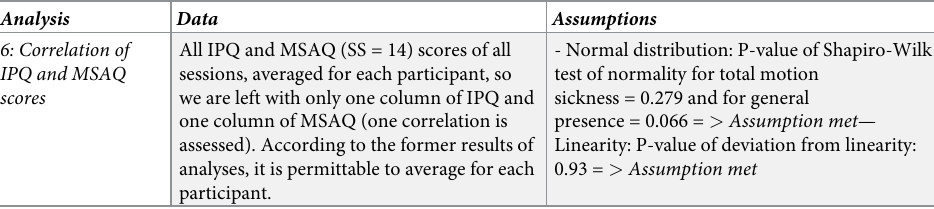
Table 5. Details of statistical procedures for the analysis